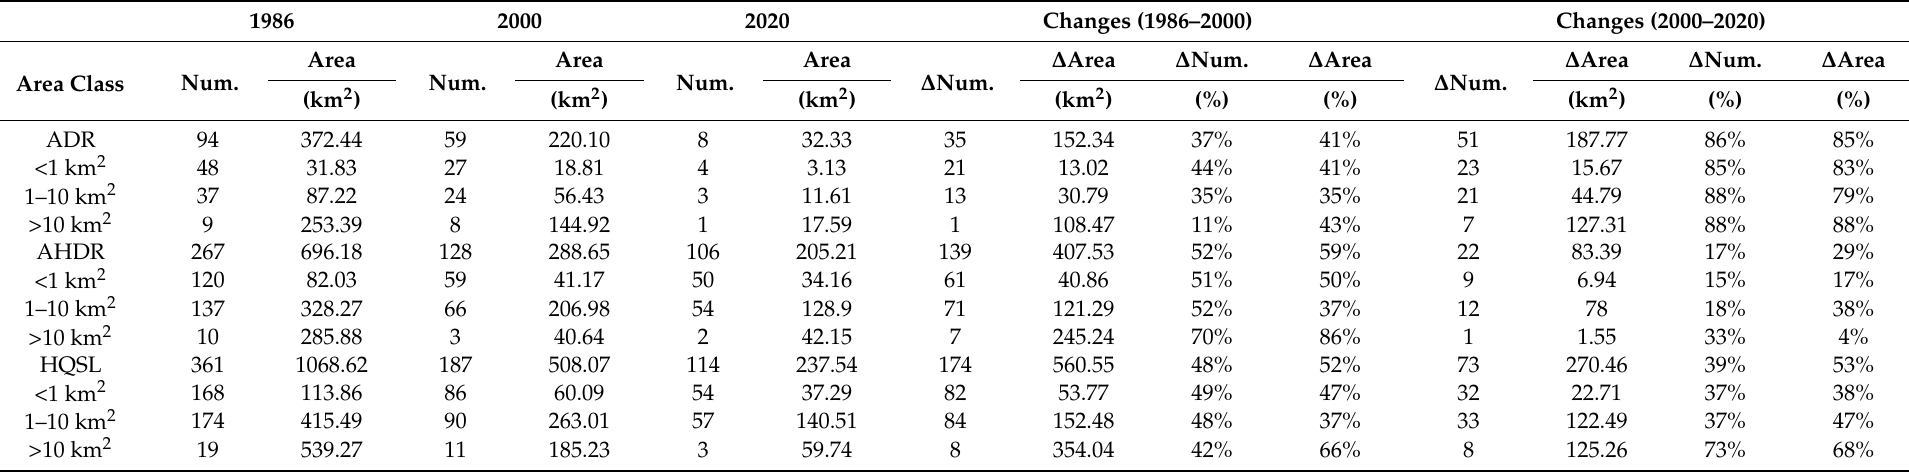
Table 4. Detailed information on changes in the area and number of SWA in HQSL during the periods 1986–2000 and